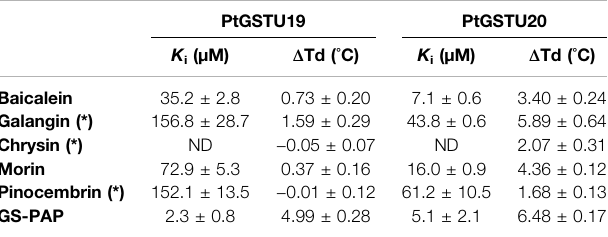
Inhibition constants have been determined toward GSH-conjugating reactions using PITC as a substrate. Δ Td corresponds to modi fi cation of the denaturation temperature which is signi fi cantly different when the protein is incubated with only DMSO. ND means that no inhibition was detected. K i was determined with GraphPad Prism 8 software using the mixed model inhibition. Flavonoids found in poplar are highlighted by an asterisk